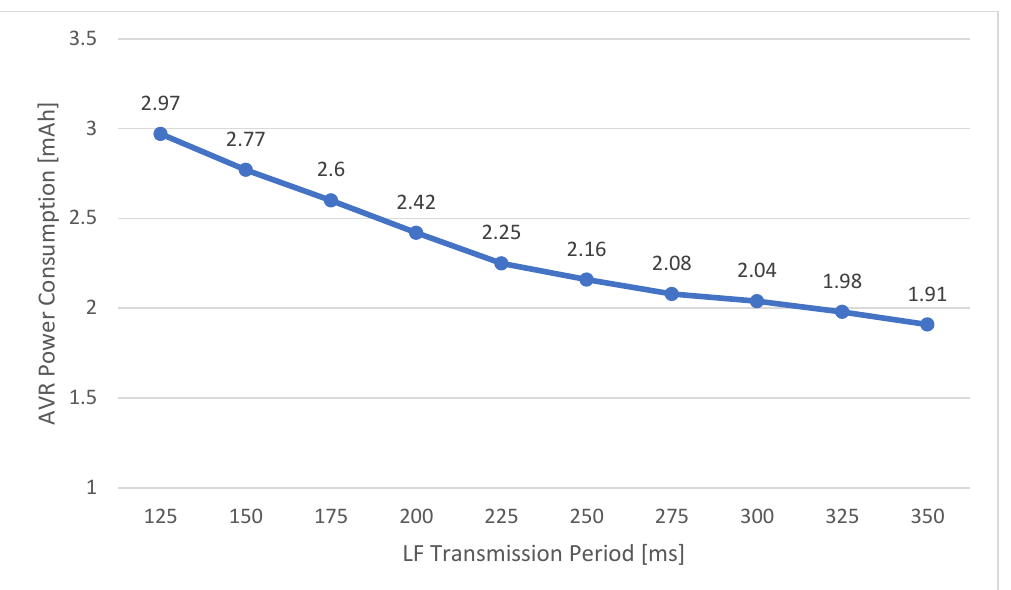
Figure 20. Power Consumption of Entrance Recognition System.